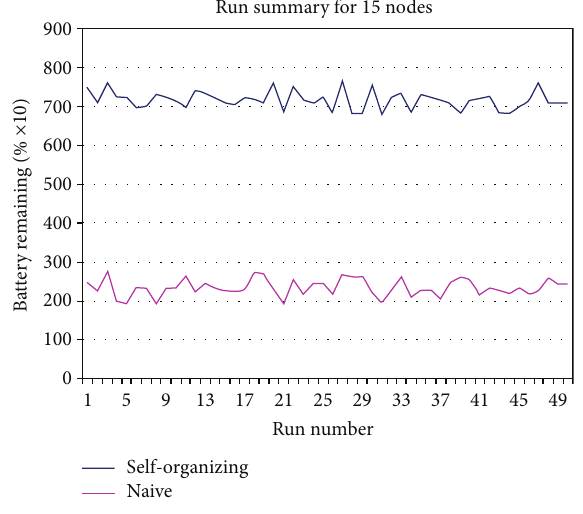
Figure 5: Simulation summary for 15